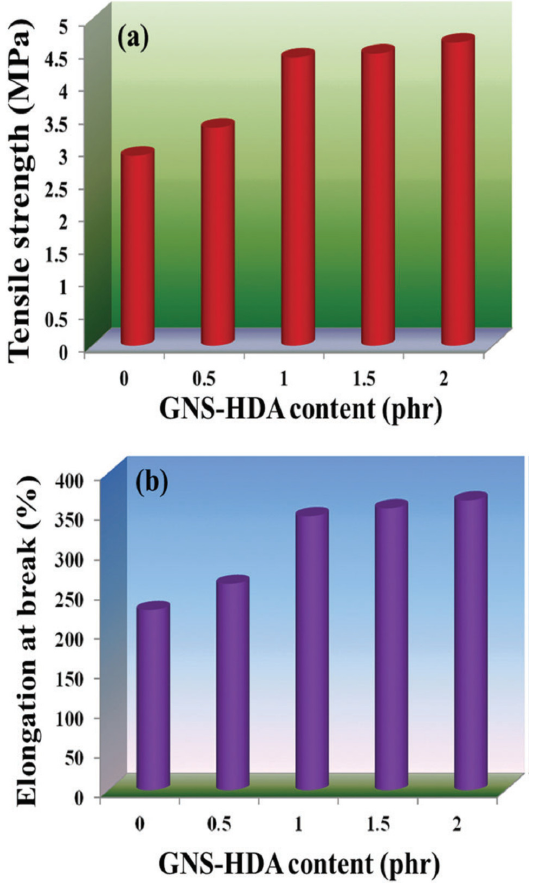
Figure 12. ( a ) Tensile strength and ( b ) elongation at break of neat carboxylated acrylonitrile butadiene rubber (XNBR) and various hexadecyl amine functionalized graphene (GNS-HDA)/XNBR composites. Reproduced with permission from [104], Copyright RSC,